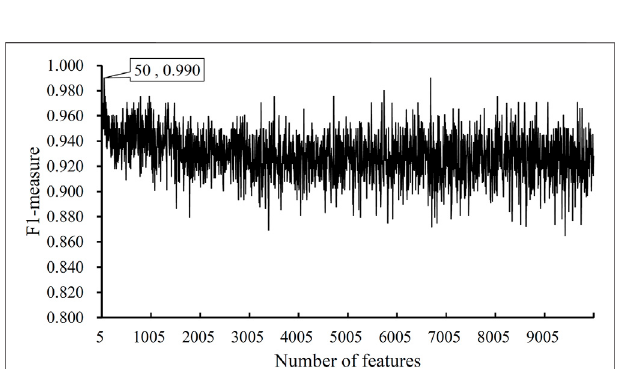
FIGURE 3 | Performance of the best DT model and DT model with informative features. The best DT model is superior to the DT model with informative